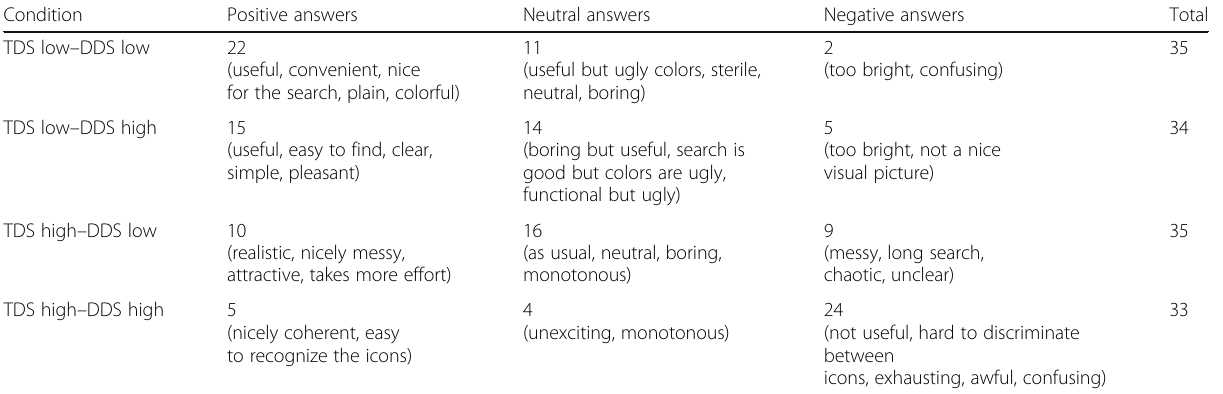
Table 4 Subjective evaluations of the similarity conditions with typical comments presented in round edges